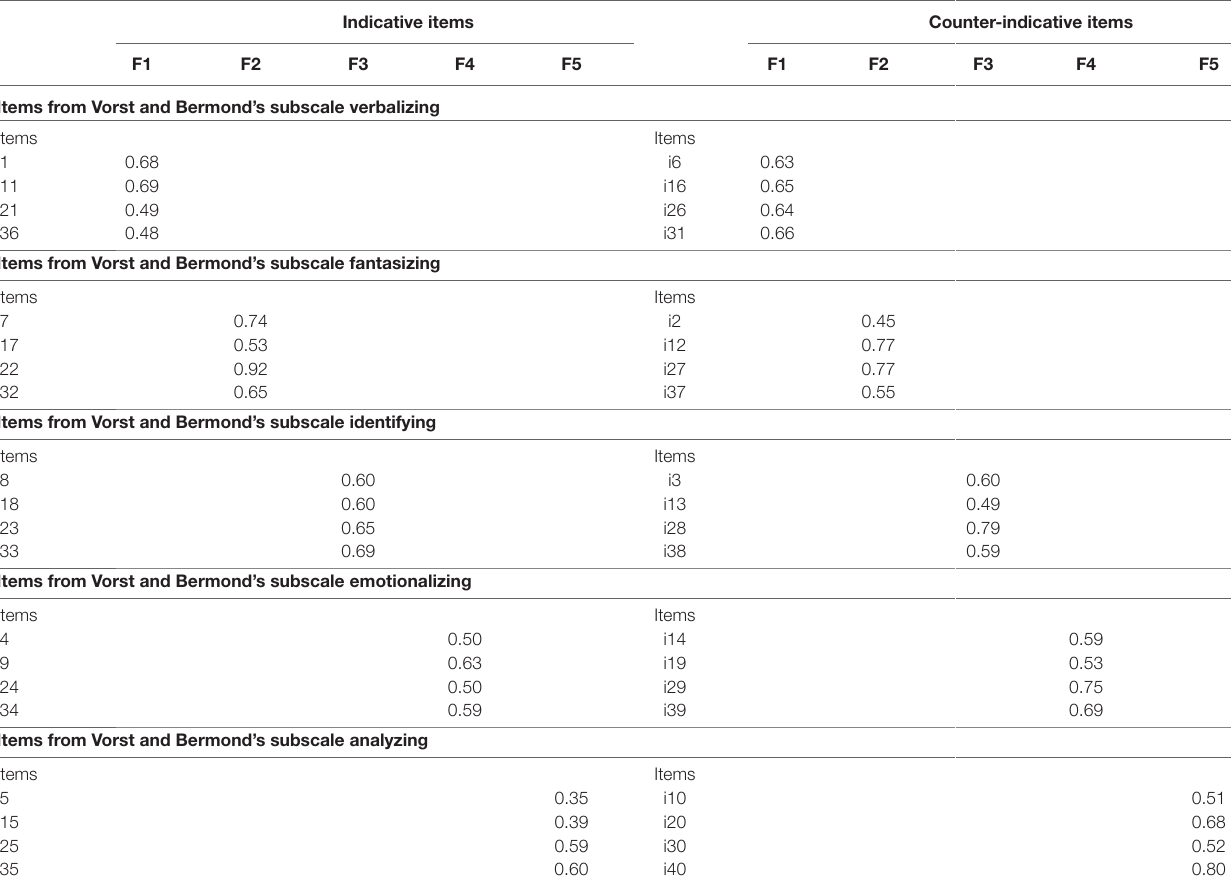
TaBle 5 | Standardized factor loadings of the five-factor model in the LISS panel data of the analysis sample, for the indicative items and counter-indicative items. indicative